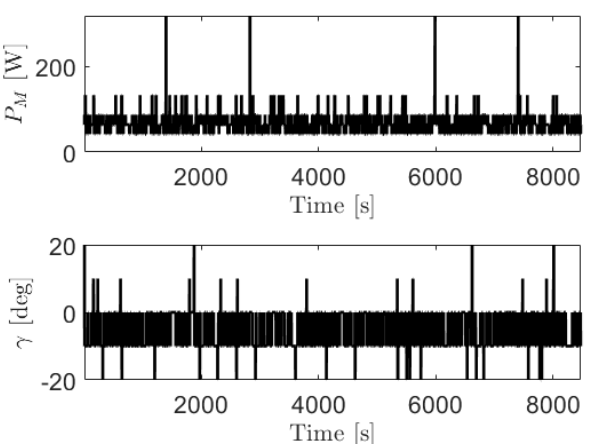
Figure 14. Battery power, Simulation Scenario II.